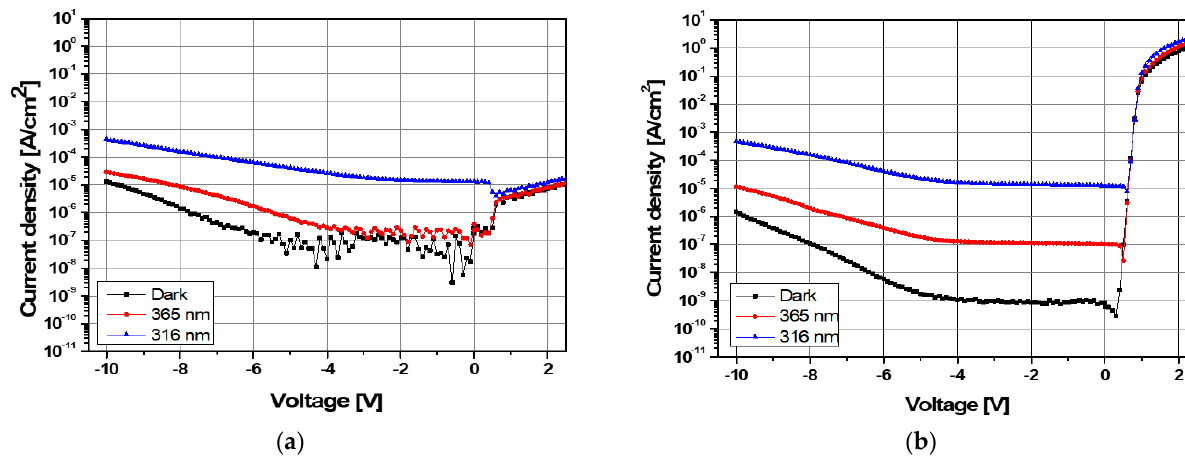
Figure 4. Dark state and UV photoresponsive I-V of the asymmetric MSM AlGaN UV sensor ( a ) before and ( b ) after selective annealing.